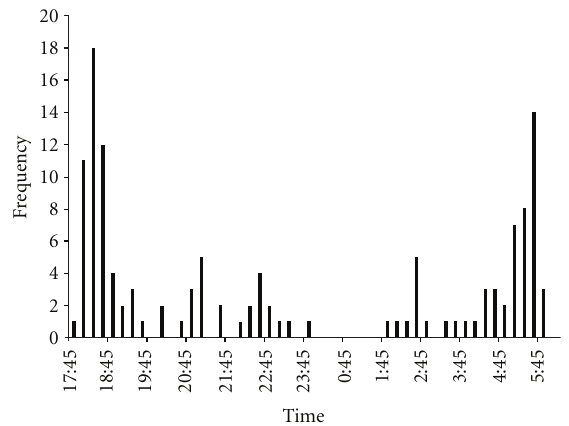
Figure 1: Histogram of distribution of acoustic activity as recorded during February and April 2010 in Bilar locality. Peak activity is shown between 18:00–18:45 and 5:00–5:45.